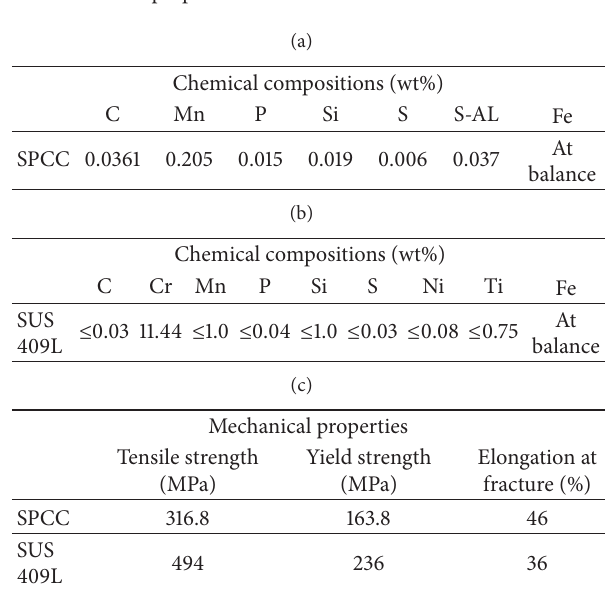
Table 1: The chemical compositions provided by the manufacturer and mechanical properties of SPCC and SUS